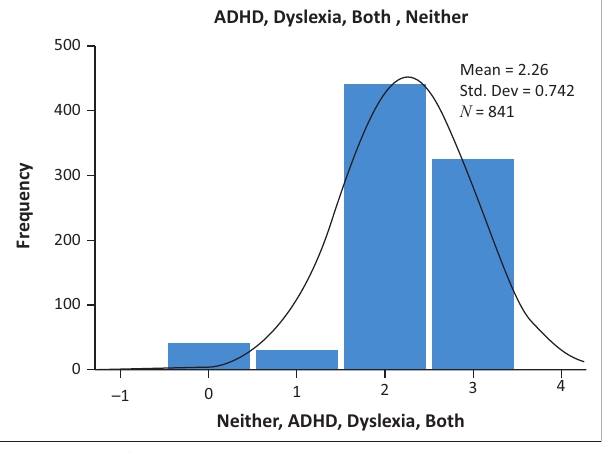
FIGURE 2: Distribution: Participants grouped according to attention deficit hyperactivity disorder and/or developmental dyslexia diagnosis.